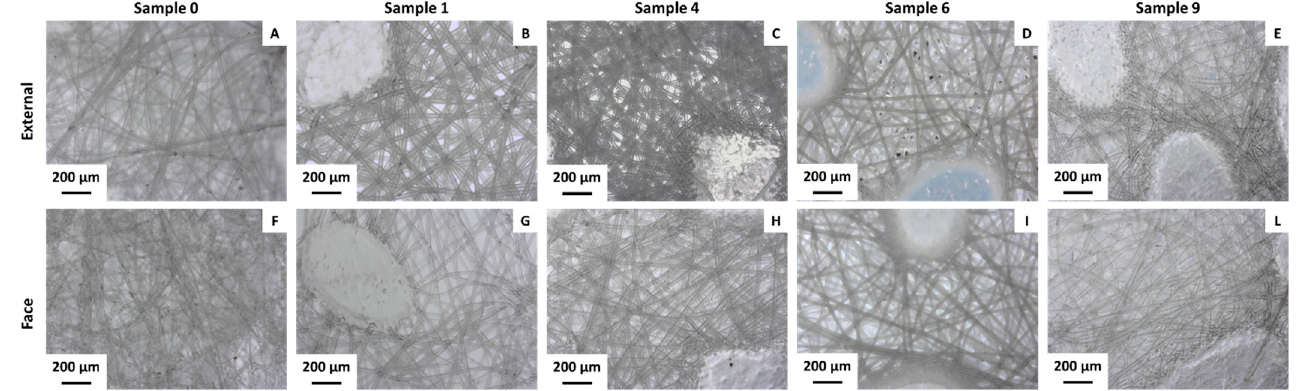
Figure 2. Optical microscope images of gold standard (sample 0) and samples 1, 4, 6, and 9 external layers ( A – E ) and face side layers ( F – L ), respectively.